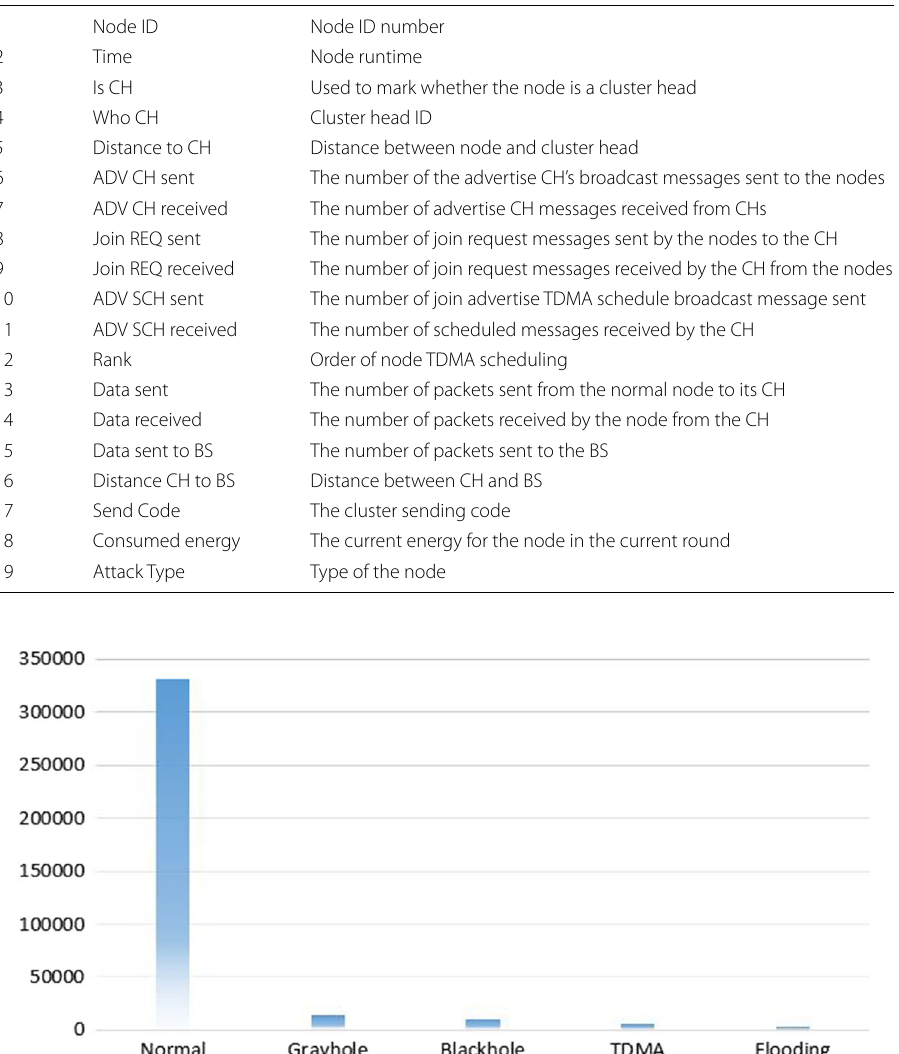
Table 4 WSN-DS dataset attributes